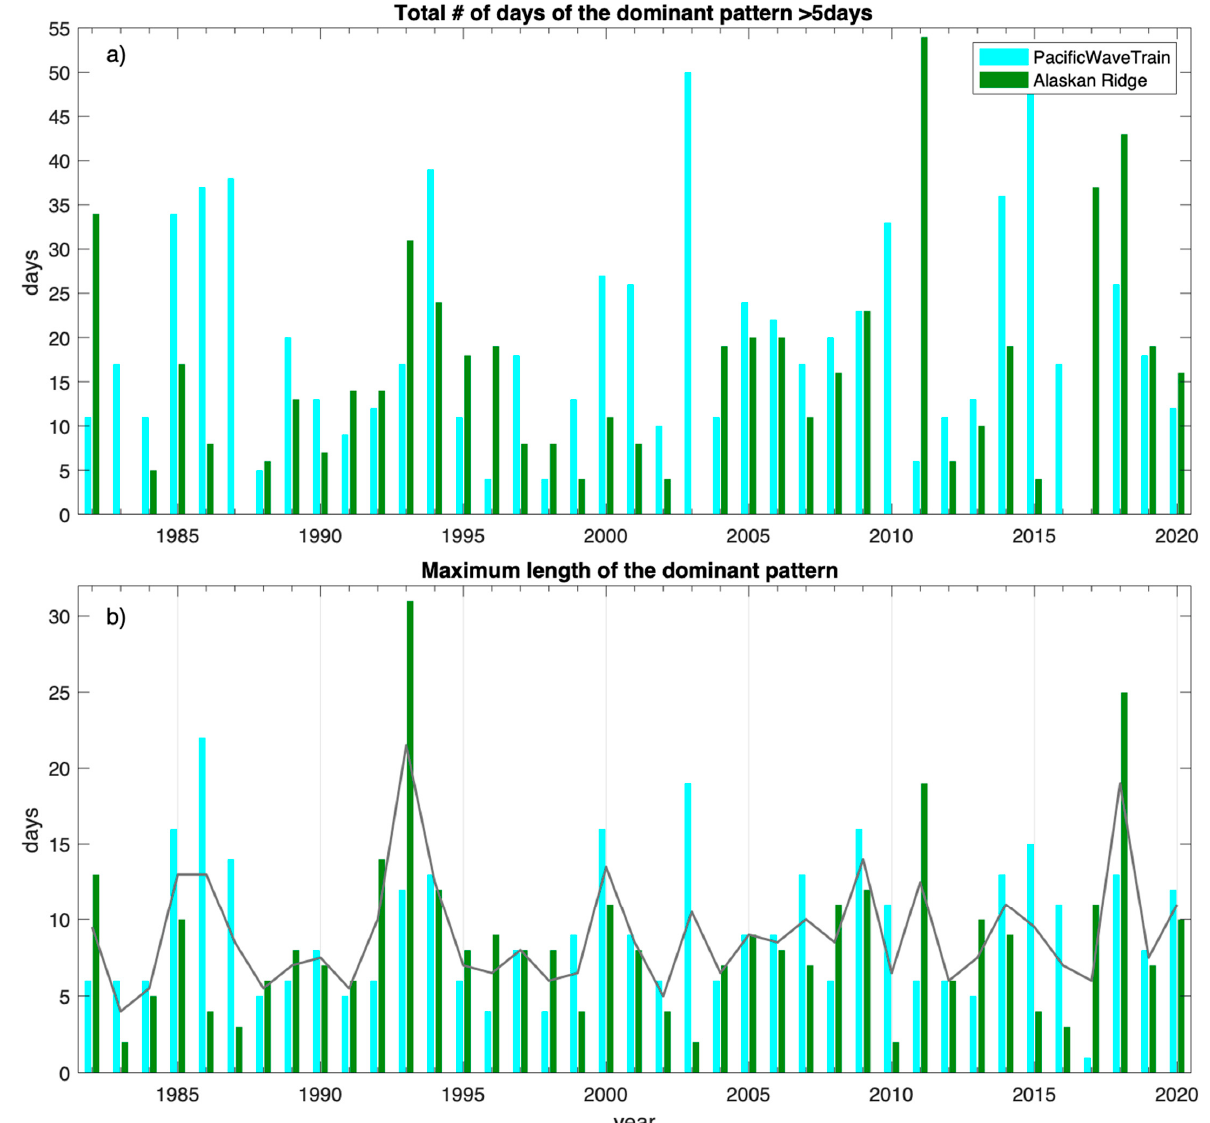
Figure 6. ( a ) The number of days in each season of the Alaskan Ridge (green bars) and Pacific Wave-Train (light-blue bars) which lasted longer than 5 days. ( b ) The duration of the longest single event for the Alaskan ridge (green bars) and Pacific Wave-Train/North American Ridge (light-blue bars) for each year. The continuous line is their